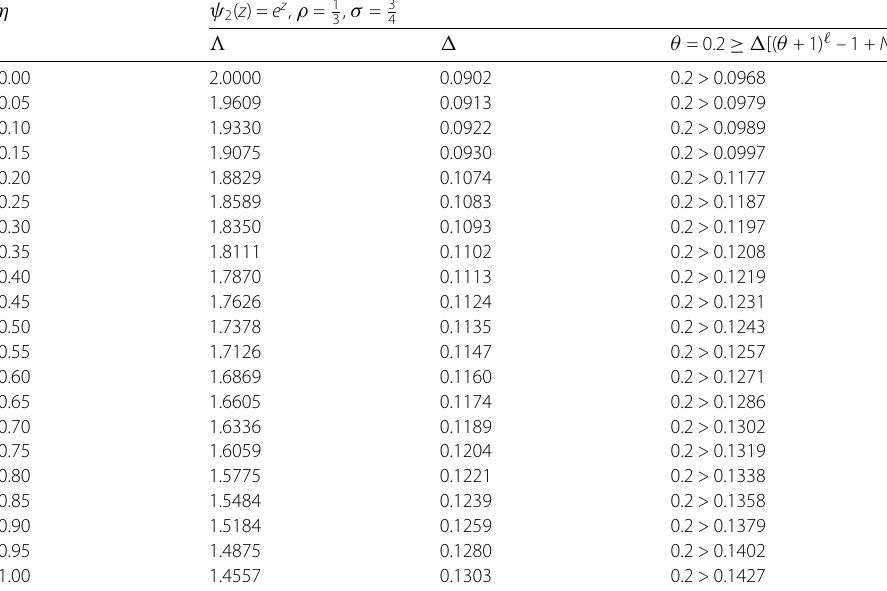
Table 2 Numerical results of (cid:27) and θ for ψ 2 ( z ) = e z and η ∈ J = [0,1] in Example 5.1 η ψ 2 ( z ) = e z , ρ = 1